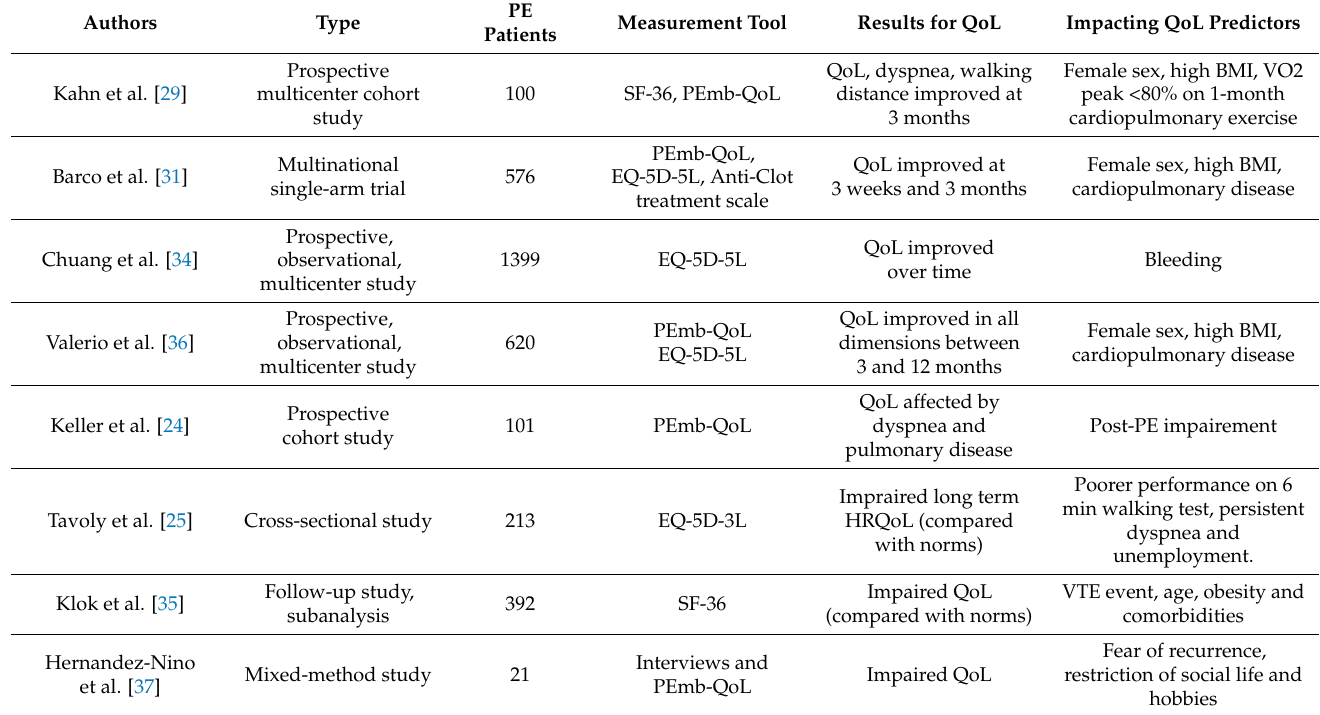
Table 1. The main findings of quality of life in Pulmonary embolism patients. The selection of studies reported in the table is based on the use of adequate QoL measures and the report of clear results of PE in